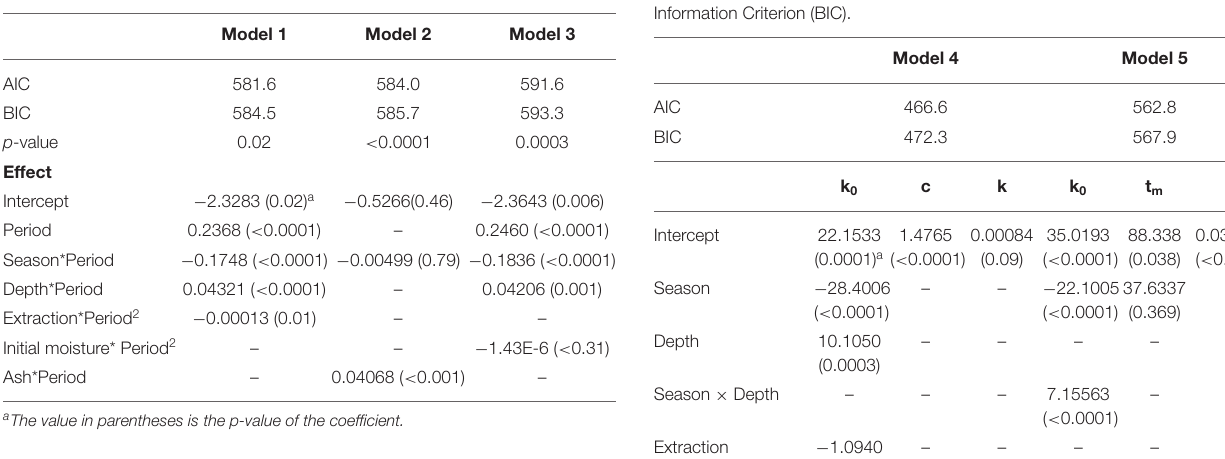
TABLE 7 | Coefficients of three mixed model candidates for dry matter loss of willow biomass when stored in piles, and Akaike Information Criterion (AIC) and Bayesian Information Criterion (BIC).